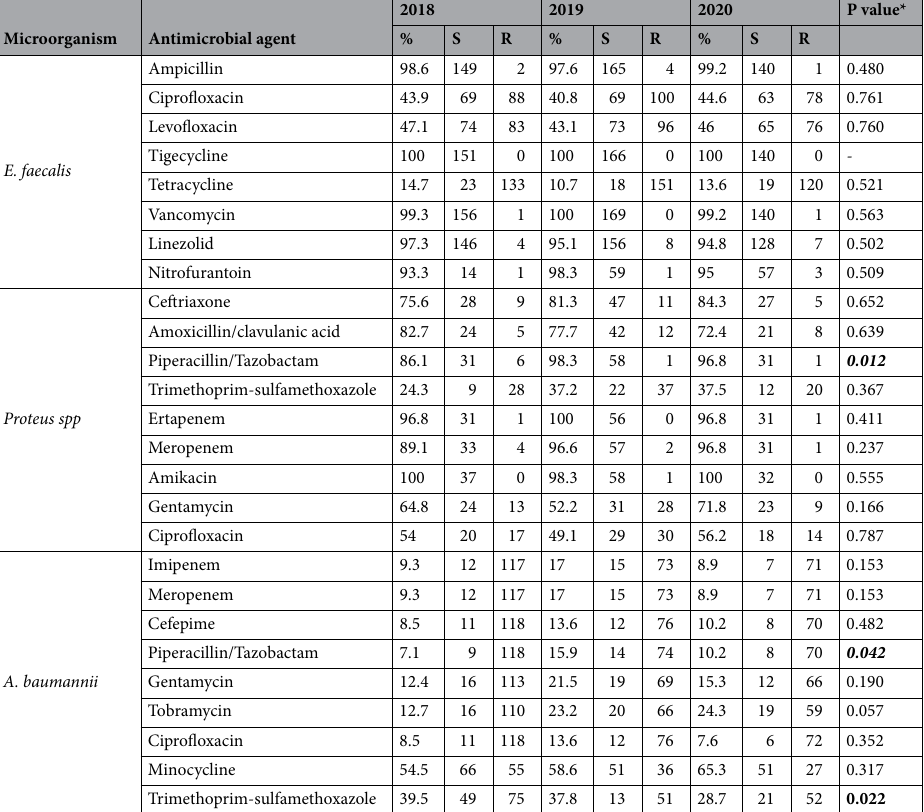
Table 3. Antibiotic Sensitivity Trends from 2018 to 2020. S, number of susceptible pathogens; R, number of resistant pathogens; %, susceptibility rate; –, not applicable. *Chi-square test; bold denotes decreasing susceptibility; bold italic denotes increasing